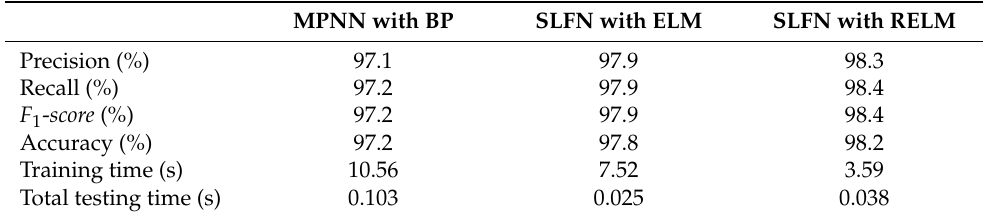
Table 8. Total performances of activation-classification models: MLNN with BP and SLFN with the ELM and